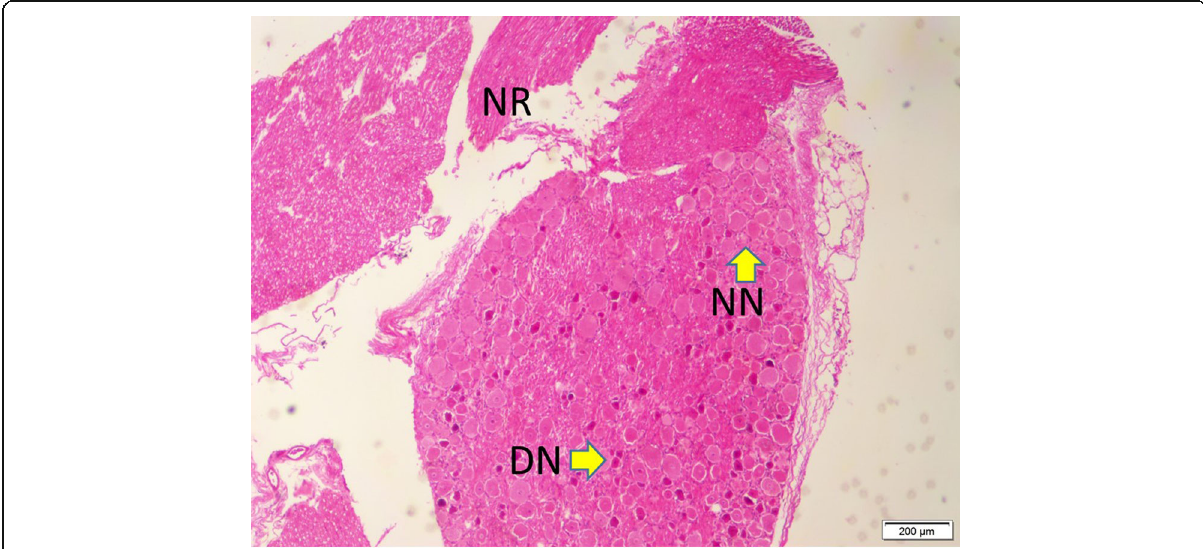
Fig. 9 Histopathological appearance of nerve roots (NR) and normal (NN) and degenerated (DN) neurons, including DRG, in an animal that underwent bipolar cautery (LM, H&E, ×